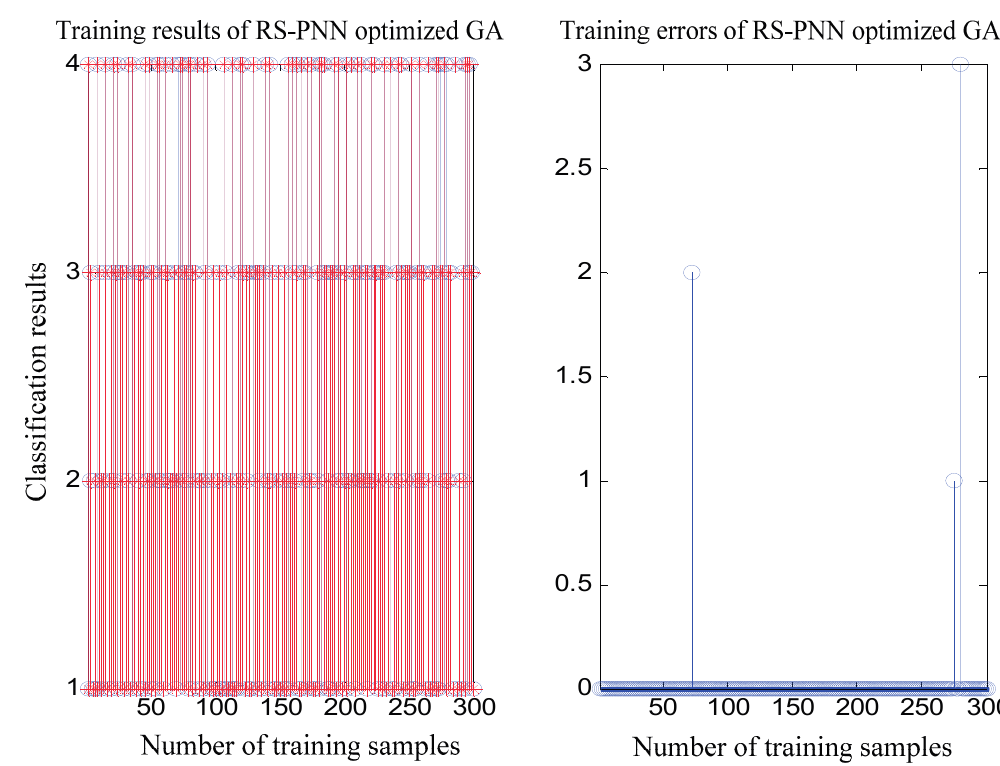
Figure 10. Classification results of RS-PNN optimized by GA under training